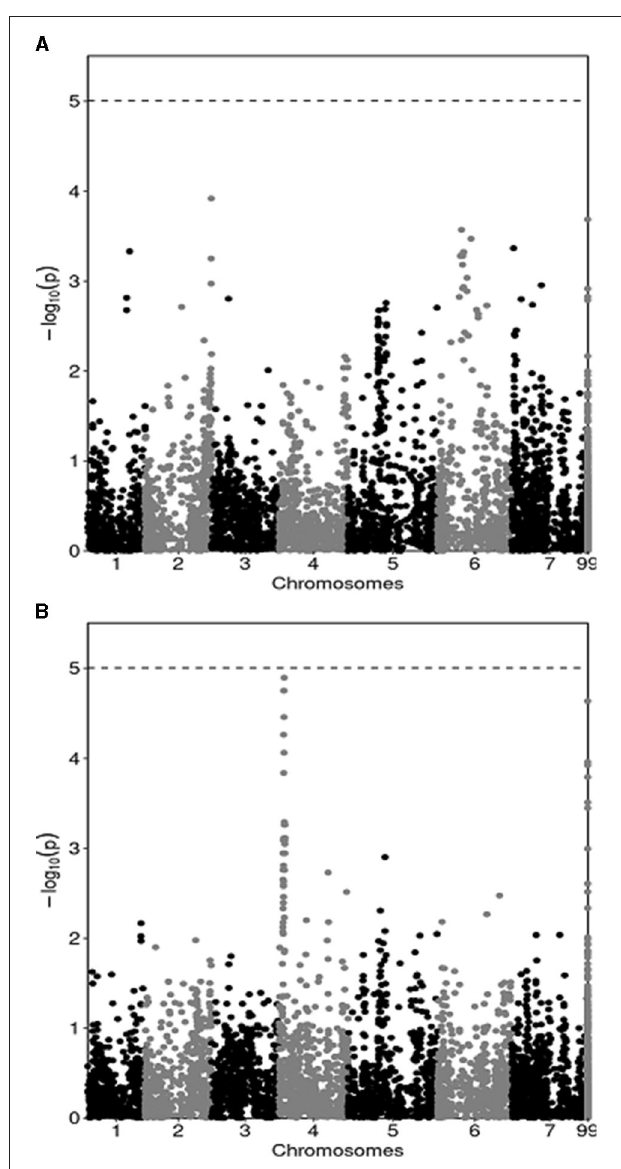
FIGURE 1 | Manhattan plots showing the association score of SNP markers along pea chromosomes with pea grain yield in mixed stand with cereals (A) and in pure stand (B) in a genome-wide association study based on yield data of 144 lines averaged across two cropping years. The dashed line represents the Bonferroni threshold at P <